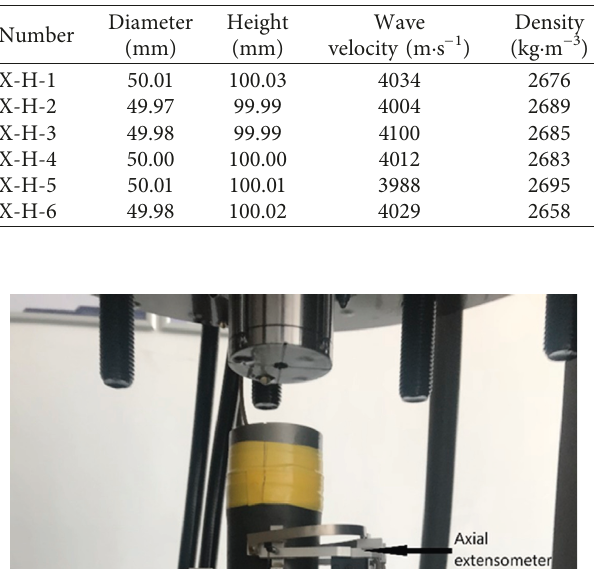
3.1. Stress-Strain Curves and Failure Modes. Stress-strain curves under 45 MPa confining pressure and failure modes under different confining pressures are shown in Figure 3. The mechanical parameters of these rocks are shown in Table 2.